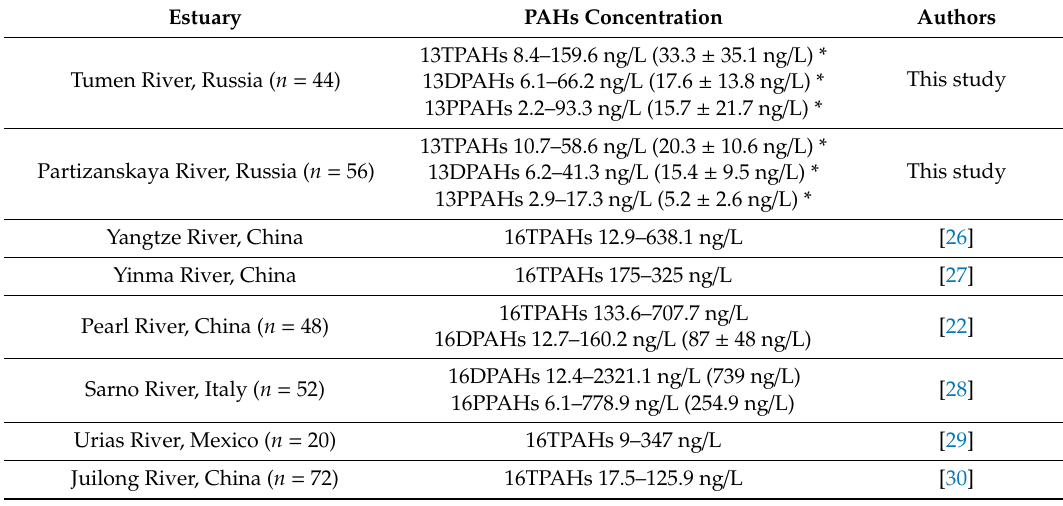
Table 1. Polycyclic aromatic hydrocarbons (PAHs) concentrations in various estuaries in the world during the past